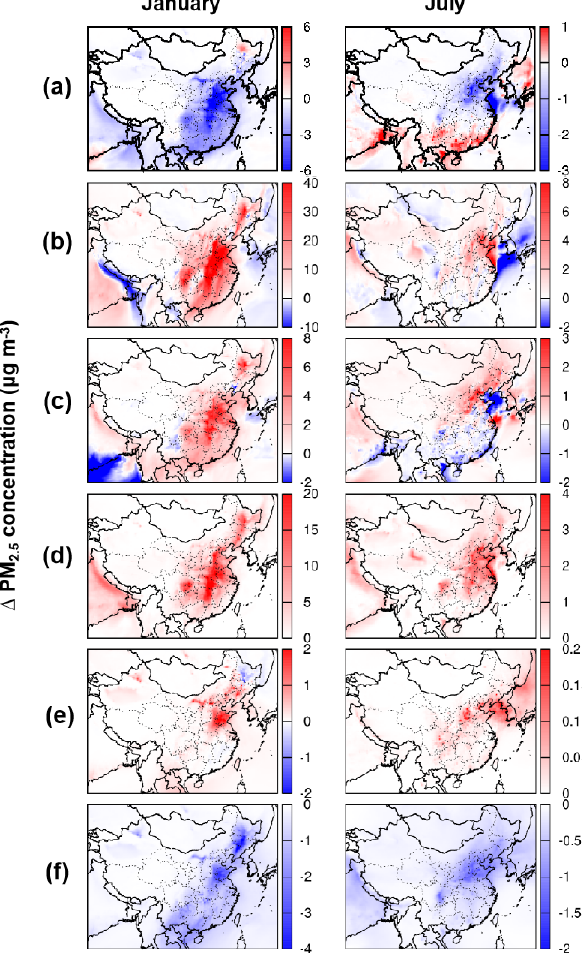
Figure 4. Changes in monthly average PM 2 . 5 concentration (µgm − 3 ) in January and July 2013 due to (a) T + 1 . 0K, (b) WS − 10%, (c) AH + 10%, (d) PBLH − 20%, (e) CLW + 10%, and (f) PCP +